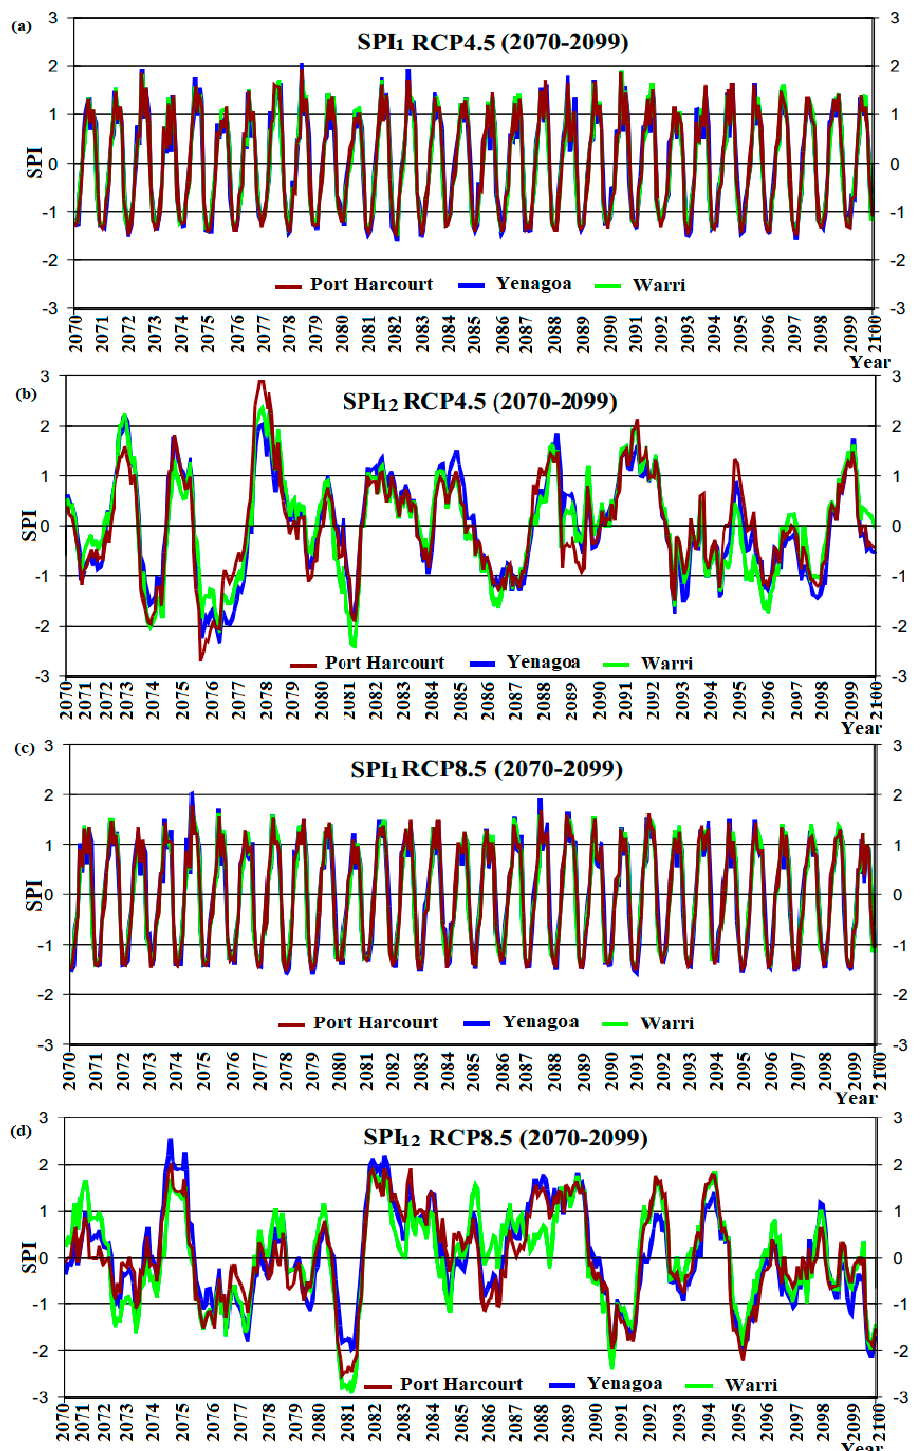
Figure 7. Computed ( a ) 1-month RCP4.5 SPI, ( b ) 12-month RCP4.5 SPI, ( c ) 1-month RCP8.5 SPI, and ( d ) 12-month RCP8.5 SPI for the projected periods from 2070 to 2099 across the study locations.